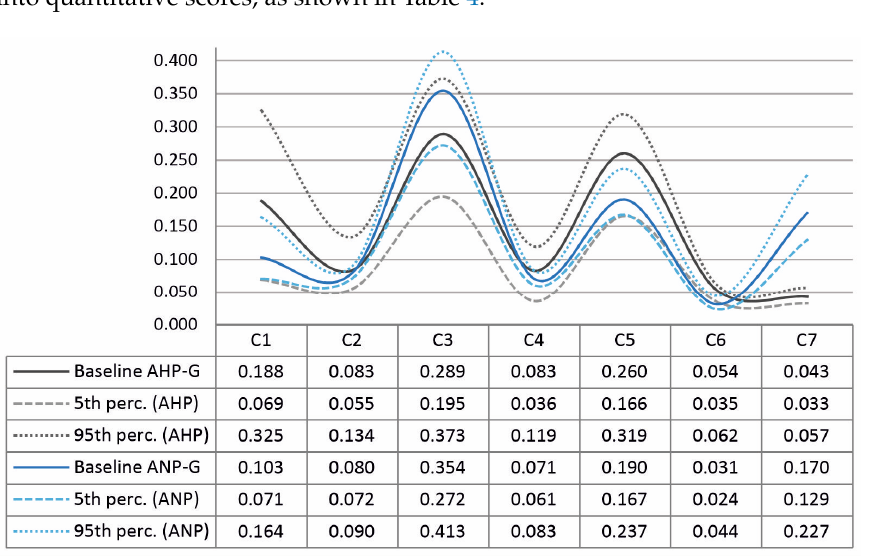
Figure 3. Dispersion in the weightings of the criteria with AHP and ANP.